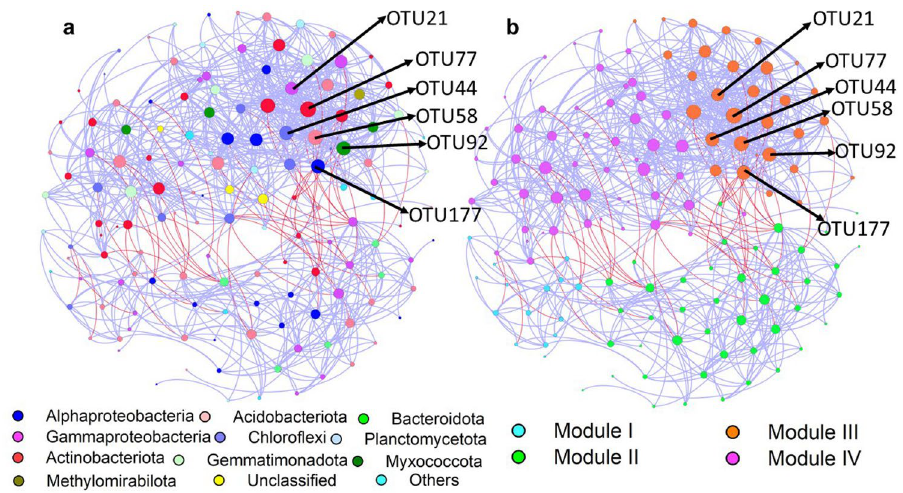
Figure 5. Interaction networks of soil bacterial community based on different N treatments. The networks are colored by phylum ( a ) and module ( b ), respectively. Modules I, II, III, and IV represent four clusters with tightly linked nodes. Size of each node is proportional to the number of connections (i.e., degree), and the thickness of each connection between two nodes (i.e., edge) is proportional to the value of Spearman’s correlation coefficients. Blue edges indicate positive interactions, while red edges indicate negative connections. The OTUs shown in networks are keystone